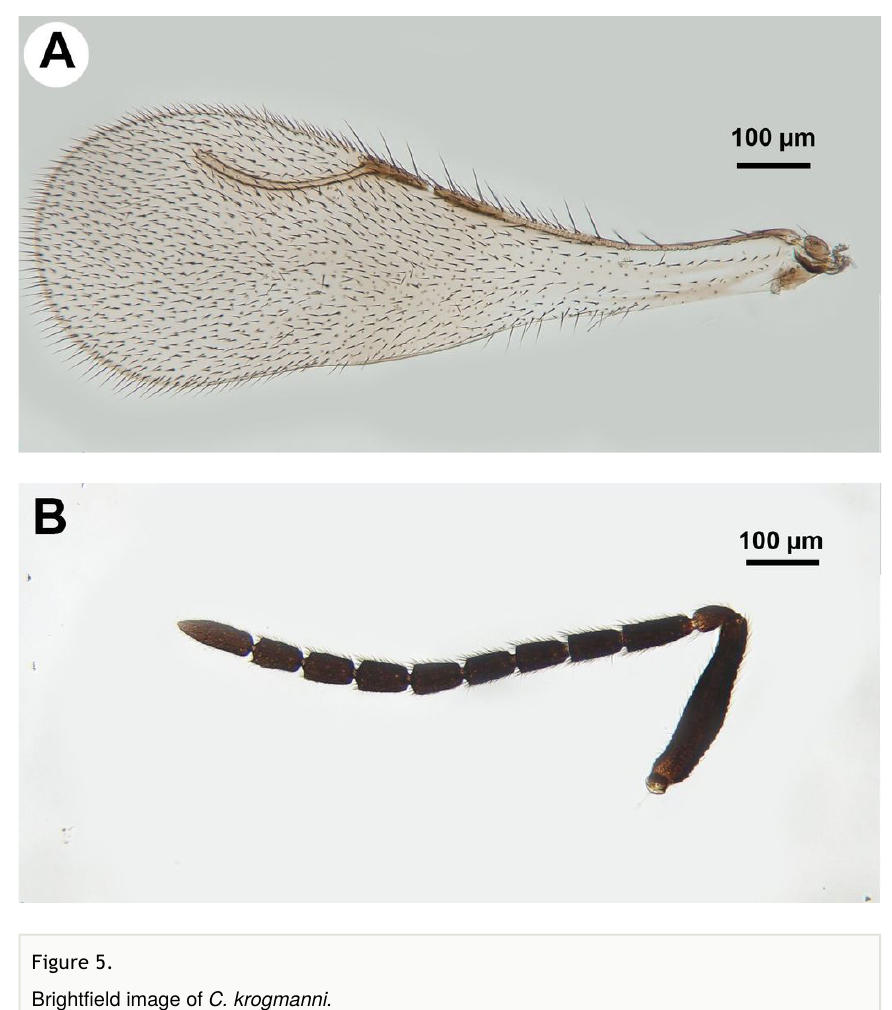
Figure 5. Bright fi eld image of C. krogmanni. a : Forewing showing reduced pterostigma and stigmal margin of Ceraphronidae. b : Antenna of Male Genitalia: Median conjunctiva of male T9 count: absent. Row of short setae delimiting apical, cercus-bearing area of male T9: present. Male T10 shape: folded along median weakly sclerotised line. Median part of male S8 structure: not constricted medially, distal margin concave. Anterior margin shape of male S9: concave. Proximal margin part of male S9 shape: concave. Male S9 distal setal line / setal patch count: distal setae composing transverse setiferous line(s). Distomedian, hairless area (interrupting transverse row of setae or patch) on abdominal sternum 9 count: present (distal setiferous patch / line separated medially). Distal margin of male S9 shape: straight. Proximolateral corner of male S9 shape: acute. proximal lobe of vas deferens: NOT CODED. Distodorsal margin of cupula shape: straight (Fig. 4a). Cupula length vs.